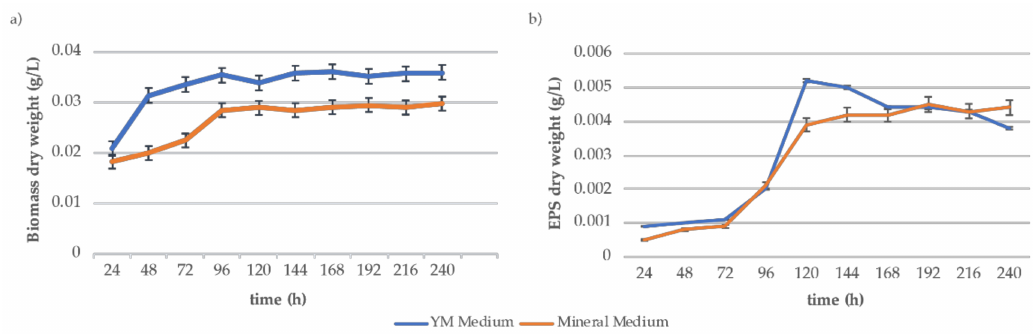
Figure 1. Biomass ( a ) and EPS ( b ) production in submerged fermentation of Rhodotorula mucilaginosa UANL-001L cultures in YM and mineral media. Cultures were maintained in the corresponding liquid medium on sterile conditions and kept in incubation for 3 days at 30 ◦ C and 250